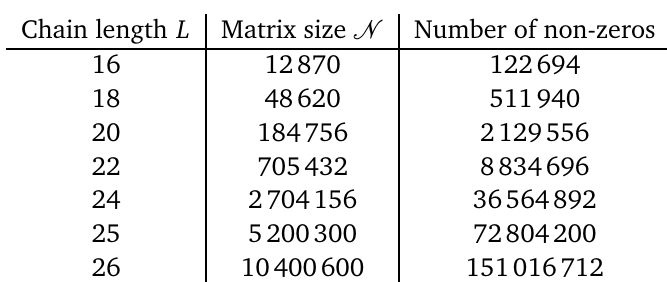
Table 1: Matrix sizes considered in this work and their number of non-zero elements of H , for chains of size L with periodic boundary conditions. Note that even